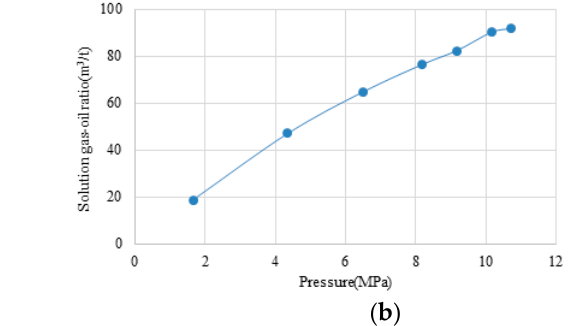
Figure 13. Some of the required physical property parameter conditions: ( a ) crude oil viscosity-pressure; ( b ) solution gas–oil